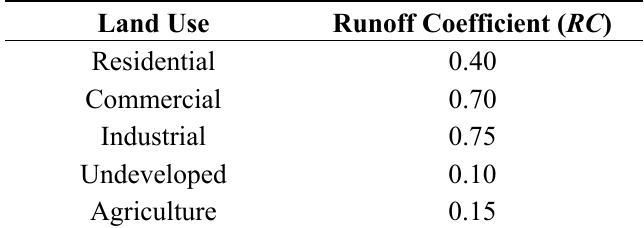
Table 3. Runoff coefficients applied to the Beauport River watershed (from